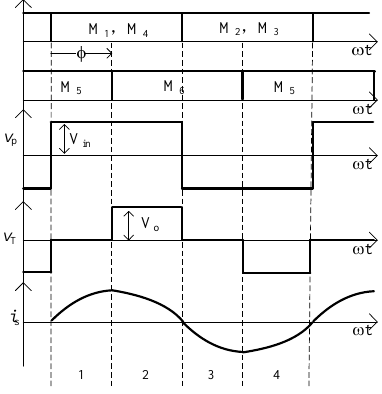
Figure 5. Steady-state waveforms of the just continuous current mode (JCCM) operation with β = 0.